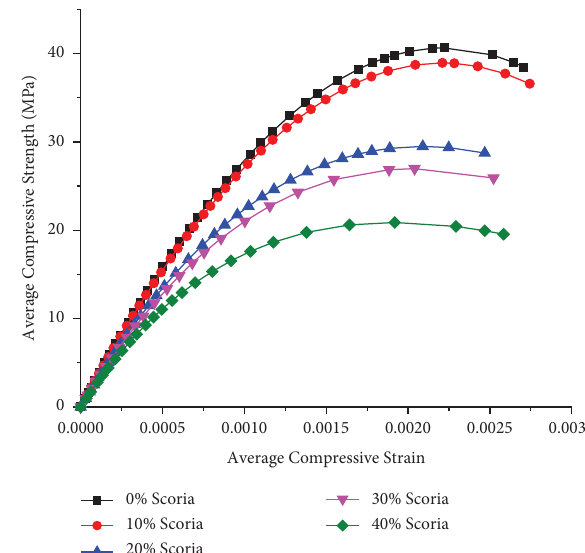
Figure 9: Stress-strain curve for 28 days compressive strength